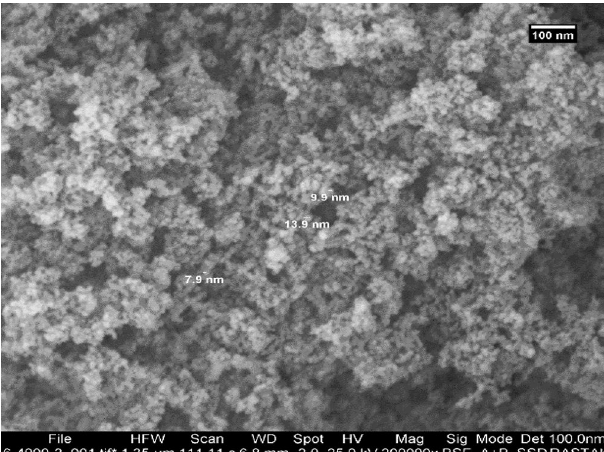
Figure 4. SEM images of the TiO 2 nanoparticles 42 .